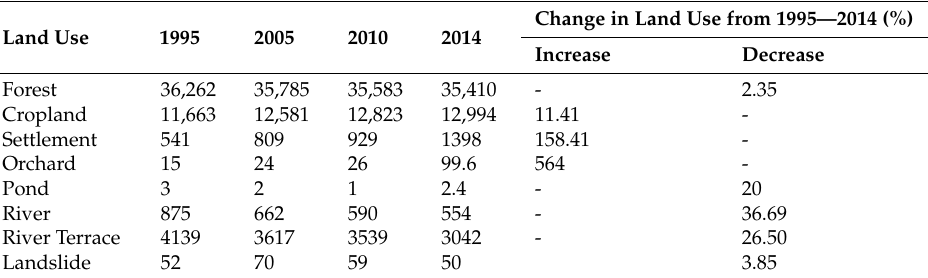
Table 4. Land use change dynamics (1995–2014).